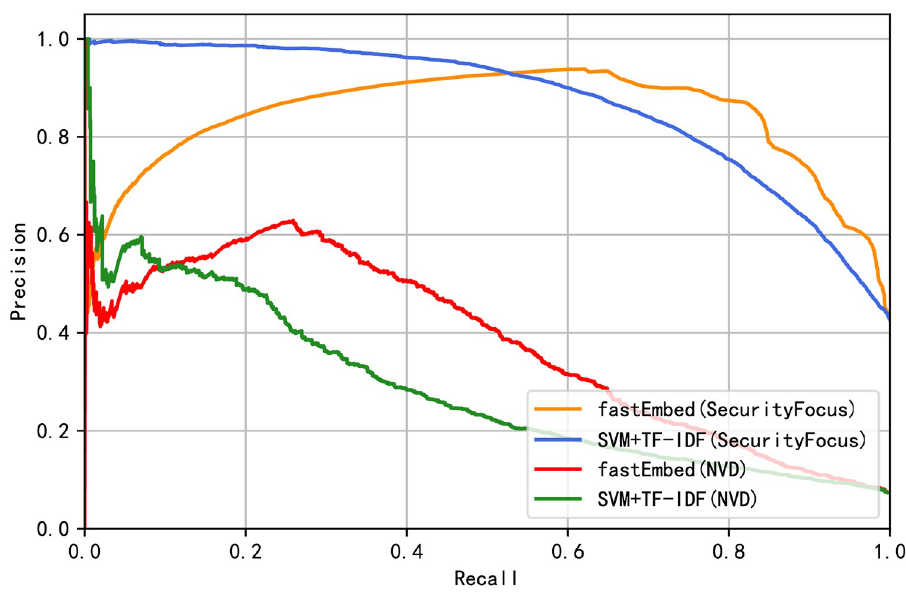
Fig 7. Precision-Recall curve of baseline model and